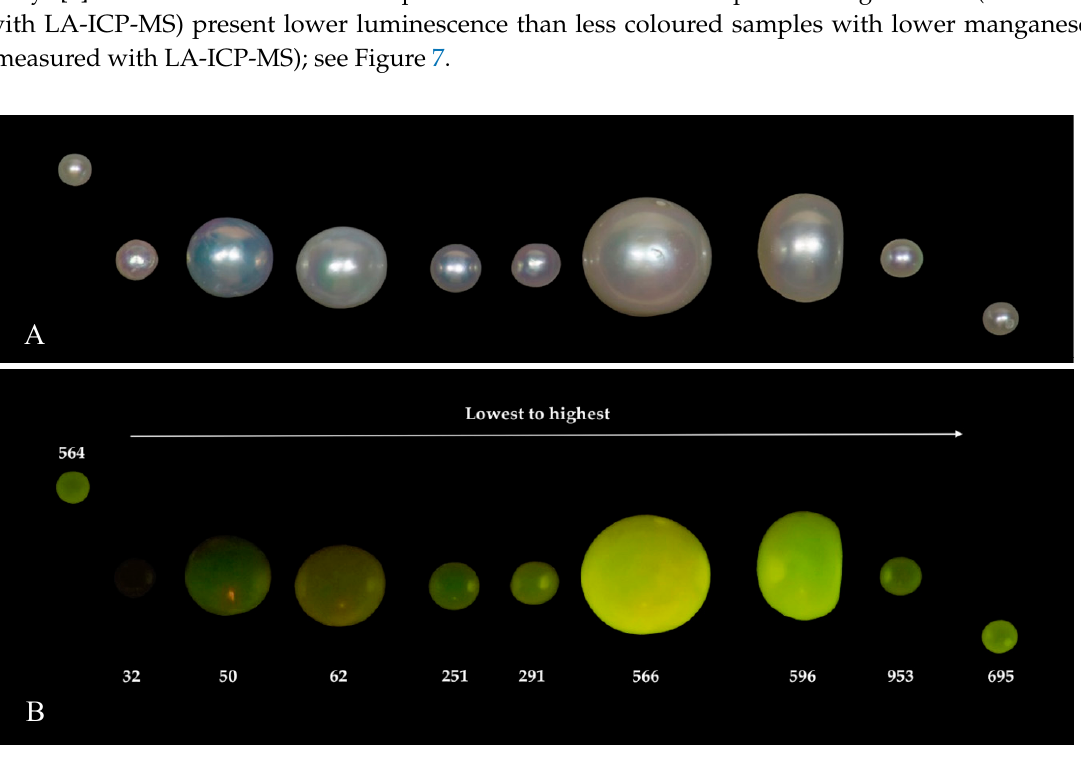
Figure 6. Freshwater samples under daylight ( A ) and under X-rays ( B ). The two freshwater samples upper left (diameter: 2.85 mm) and bottom right (diameter: 2.95 mm) used as reference. The concentrations of 55 Mn in ppmw are mentioned below for the studied samples and above for the reference samples. For the samples 3 analyses with LA-ICP-MS were acquired, the average values are presented (rounded to the nearest one).